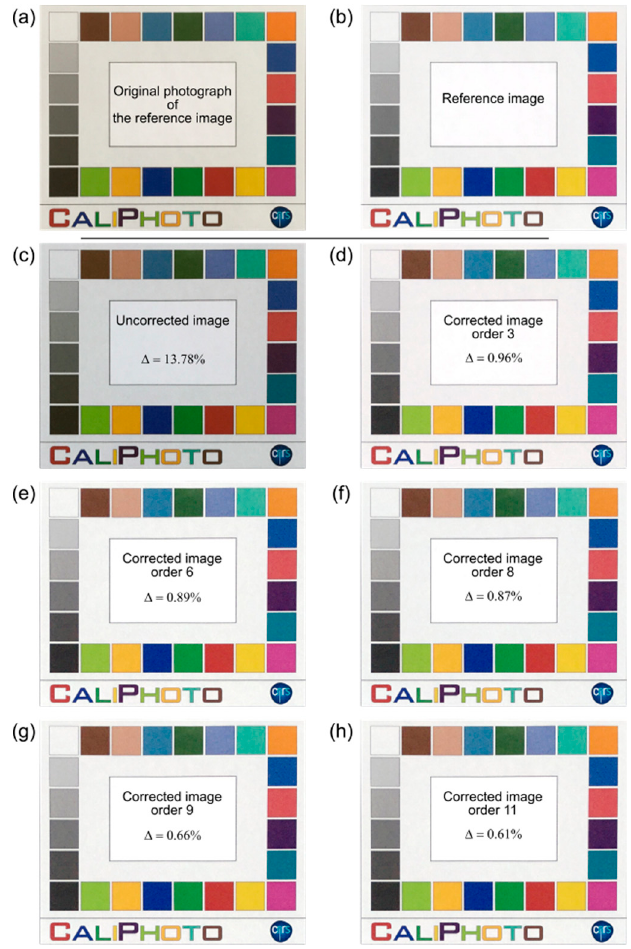
Figure A5. Effect of the order of colour correction on the accuracy of CaliPhoto image processing. ( a ) Original photograph of the colour plate used as reference. ( b ) The same image after reference image processing (see Appendix B). ( c ) Original photograph of the image to correct. ( d – h ) Corrected images using different orders for colour correction, from order 3 to order 11. The value of Δ , given by Equation (1), is reported on each image. The best correction is obtained at order 11 ( Δ = 0.61%). Photographs taken using a tablet camera (iPad).